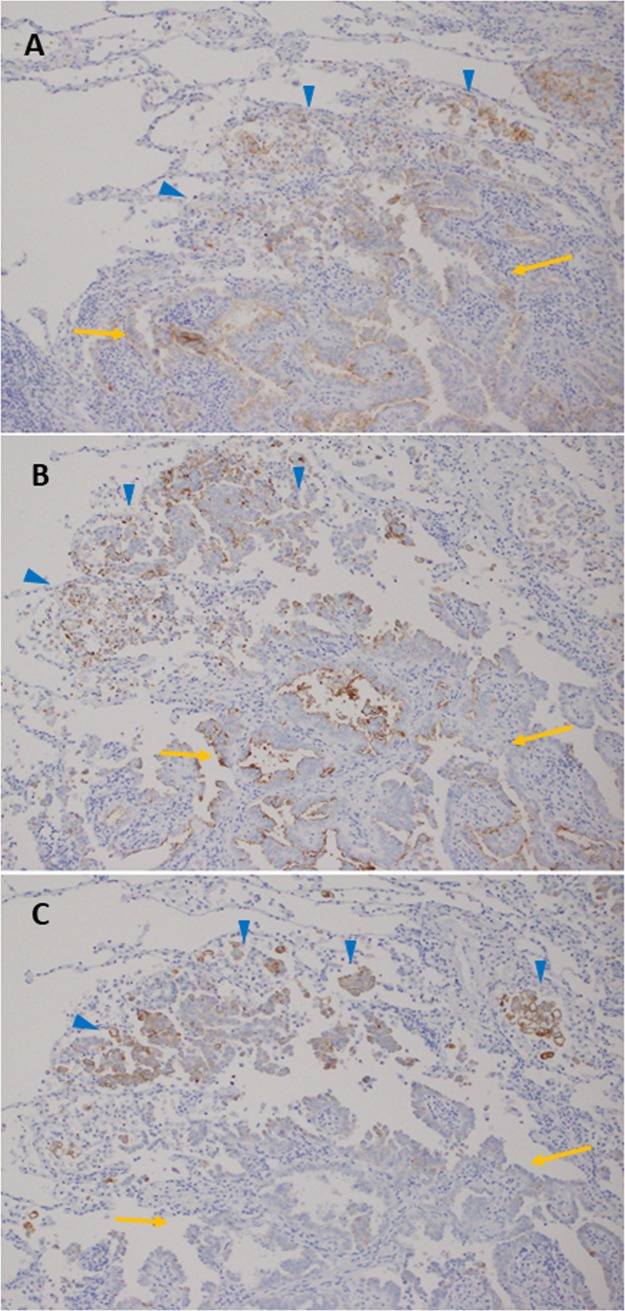
Representative images of three different varieties of MUC21 immunohistochemical expression.MUC21P (A) and MUC21C (B) were expressed in lepidic elements with low papillary structure (yellow arrow) and micropapillary (mPAP) elements (blue arrowhead). MUC21D (C) was expressed only in mPAP elements (blue arrowhead). Magnification of all images is 100×.